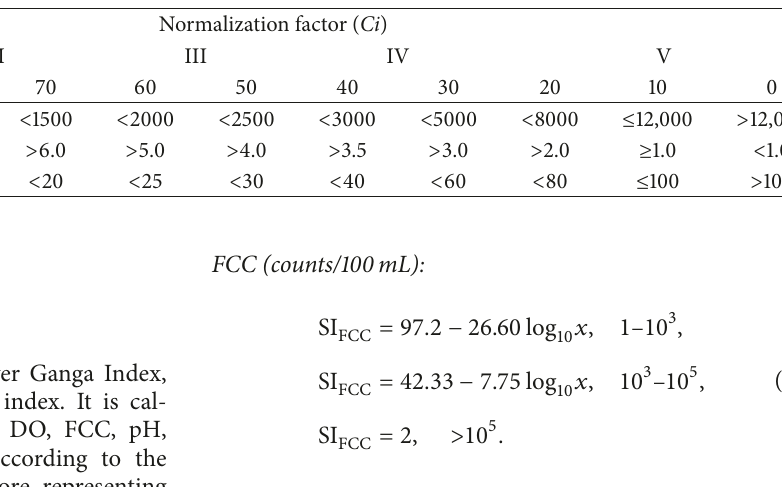
Table 2: Values of parameters after normalization for WQI min (Pesce and Wunderlin,